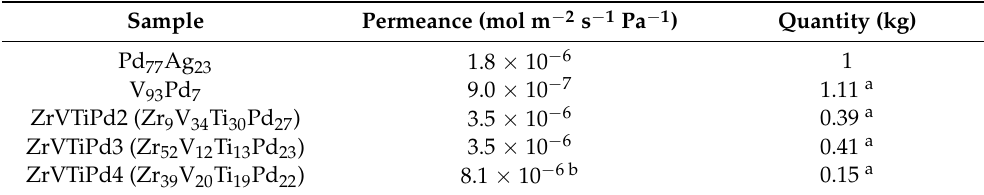
Table 3. Reference flow used for the life cycle impact assessment (membrane mass ratios calculated relative to a Pd 77 Ag 23 membrane prepared by the same method; permeances measure at 350 ◦